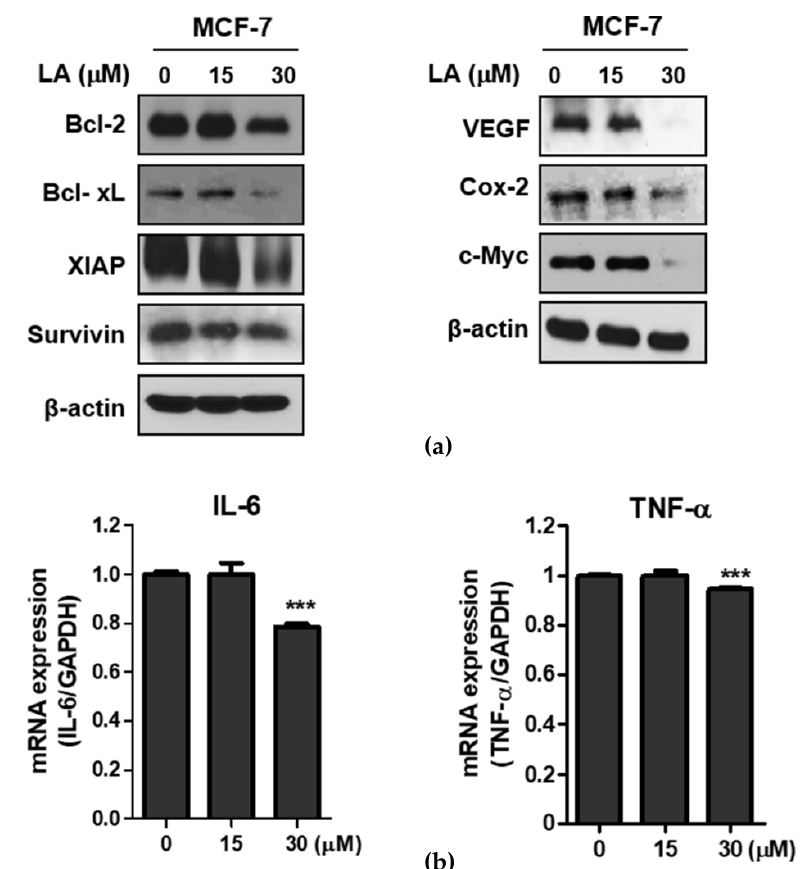
Figure 3. E ff ect of LA on NF- κ B-regulated proteins in MCF-7 cells. ( a ) E ff ect of LA on NF- κ B-modulated genes in MCF-7 cells. The MCF-7 cells were treated with LA (0, 15, and 30 µ M) for 24 h, and were subjected to Western blotting for Bcl-2, Bcl-xL, XIAP, survivin, VEGF, COX-2, c-Myc, and β actin. ( b ) E ff ect of LA on TNF- α and interleukin 6 (IL-6) at the mRNA level in the MCF-7 cells by qRT-PCR. Data stand for means ± SD. *** p < 0.001 vs. untreated control.